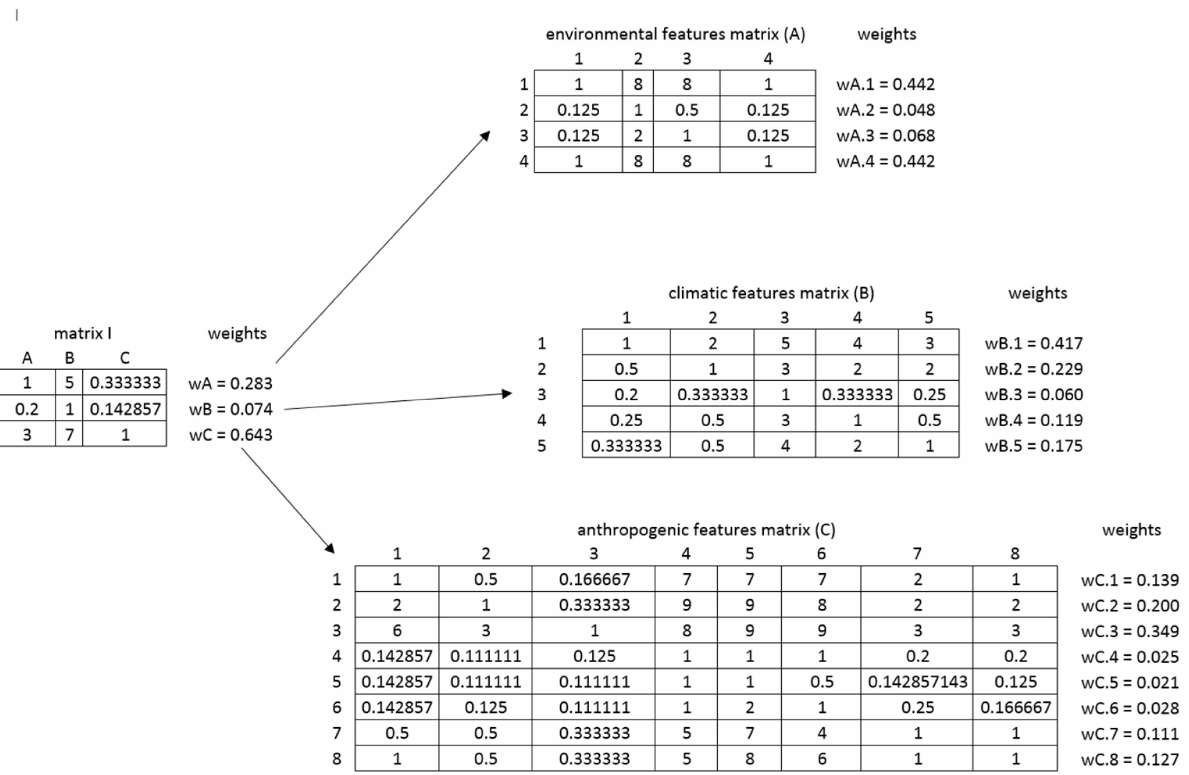
Figure 7. PV farm location criteria paired comparison matrices. Source: Own study.